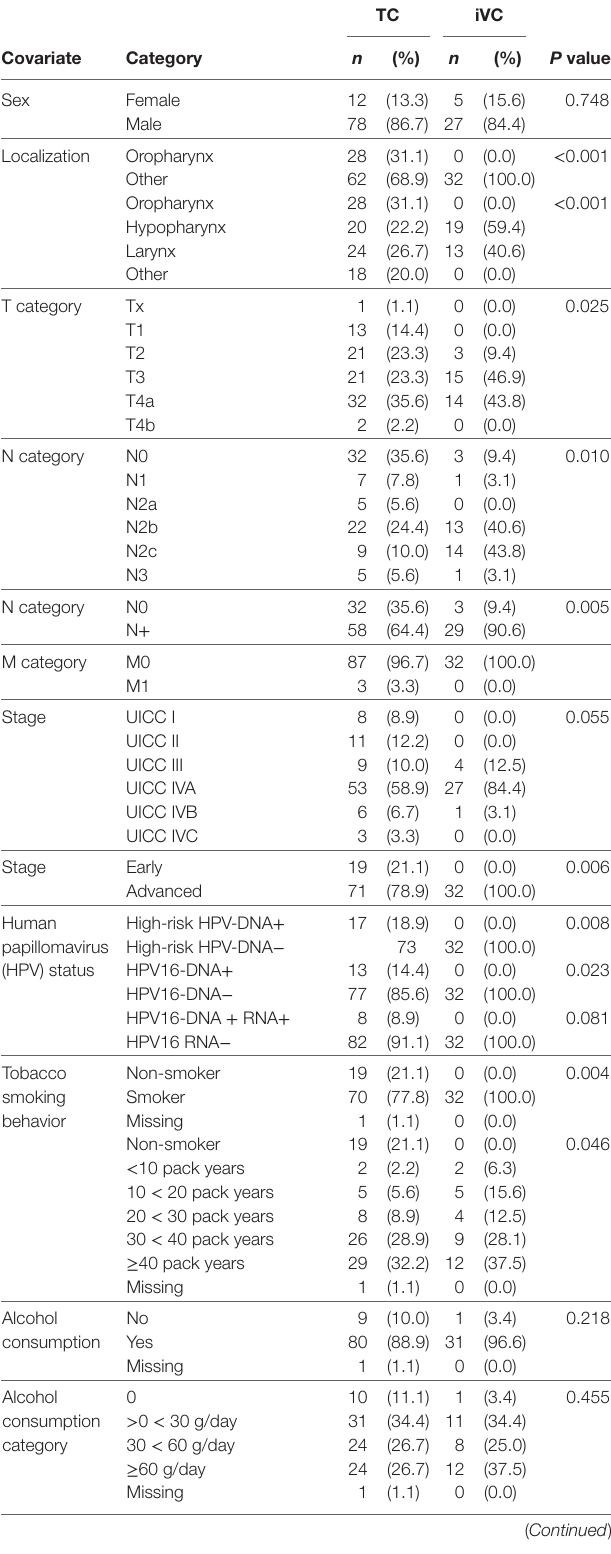
TaBle 1 | Main characteristics of the head and neck squamous cell carcinoma patients of the test cohort (TC; N = 90) and independent validation cohort (iVC; N = 32)